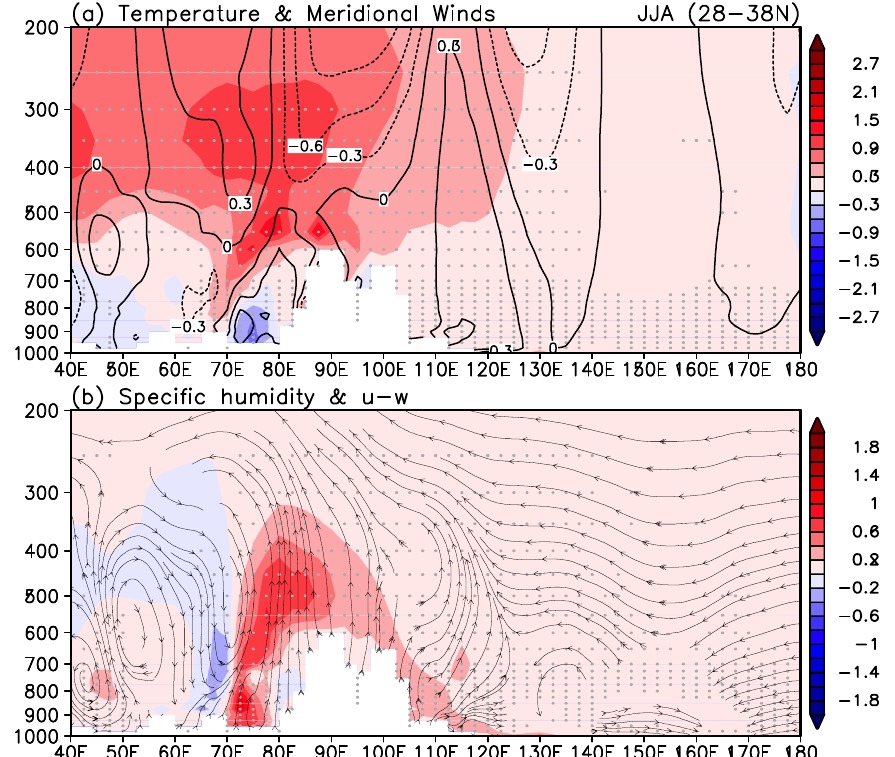
Figure 5. Height–longitude cross-section of June–July–August mean anomalies averaged over (28–38° N) of ( a ) temperature (°C) and meridional winds (m s −1 ), and ( b ) specific humidity (g Kg −1 ) and streamlines of anomalous east–west circulation spanning the Middle East to the western Pacific (40° E–180°). Statistically significant values exceeding 95% are indicated by grey dots.